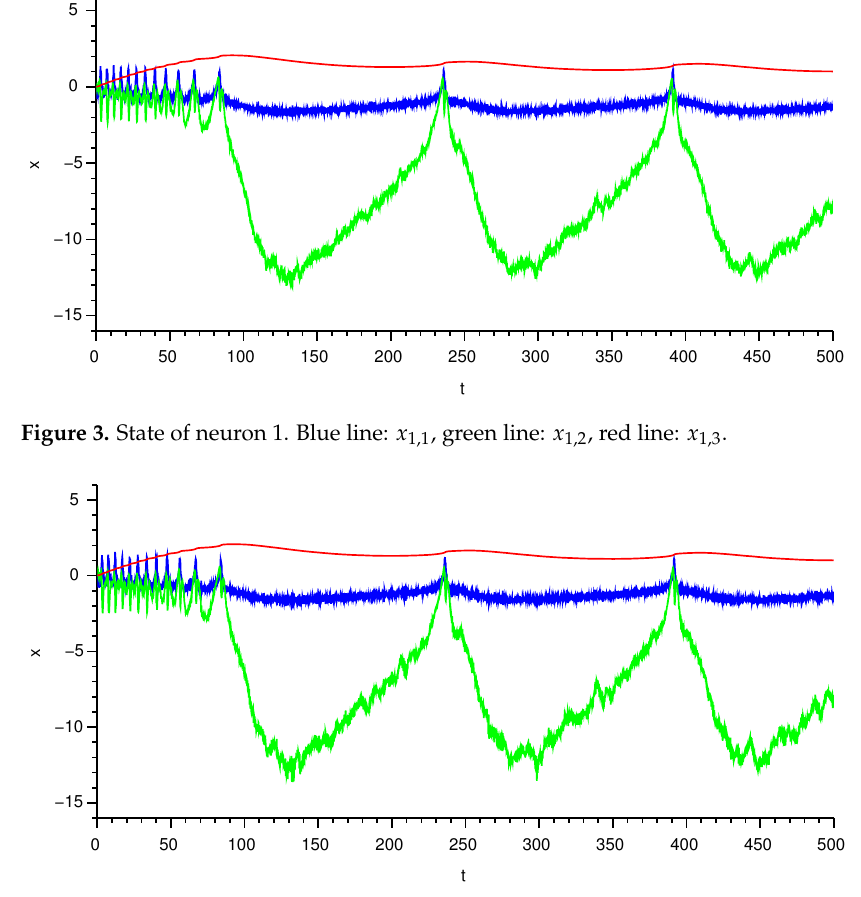
Figure 4. State of neuron 3. Blue line: x 3,1 , green line: x 3,2 , red line: x 3,3